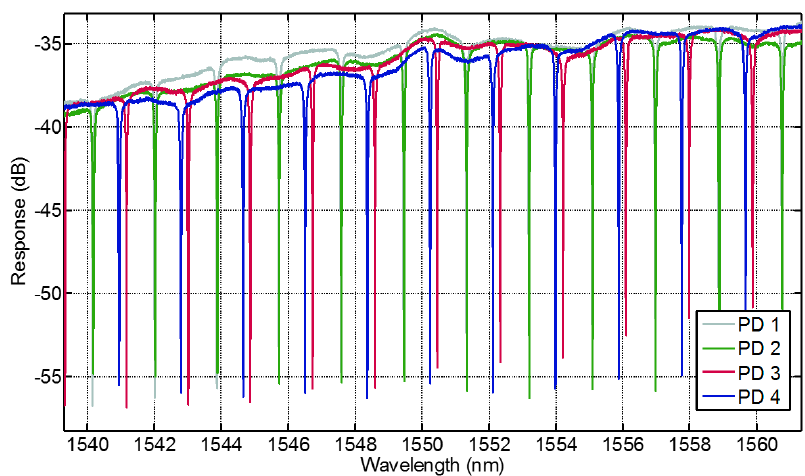
Figure 6. Measurements taken by the photonic sensor. Depicted is the response of four different optical ring resonators of one photonic sensor. The response signals are well defined and each separate frequency shift of one optical ring resonator can be easily